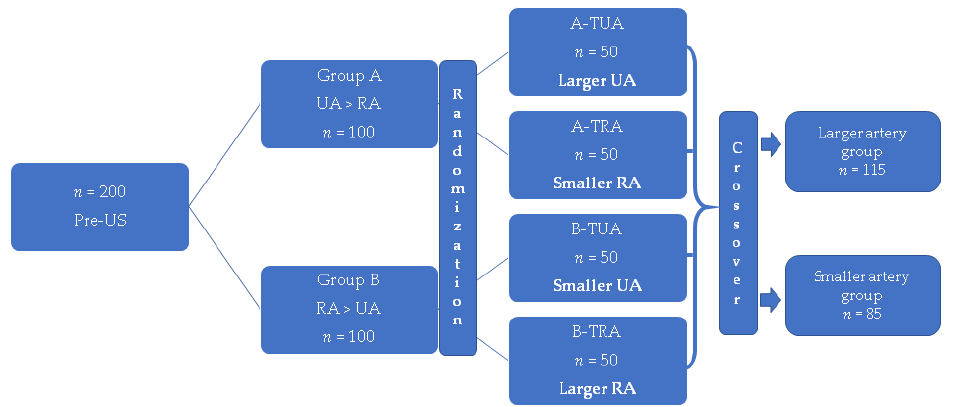
Figure 1. Stratified randomization of patients into larger or smaller artery groups. Pre-US–pre- procedural ultrasonography, RA–radial artery, UA–ulnar artery, TUA–transulnar access, TRA– transradial access